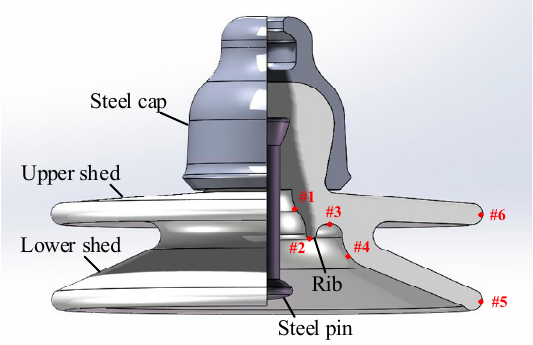
Figure 3. Structural characteristics of